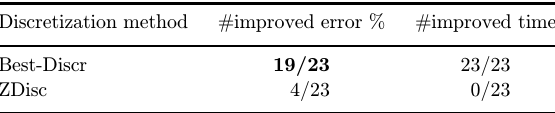
Table 11. Overall comparison of Best-ULR-Discr with